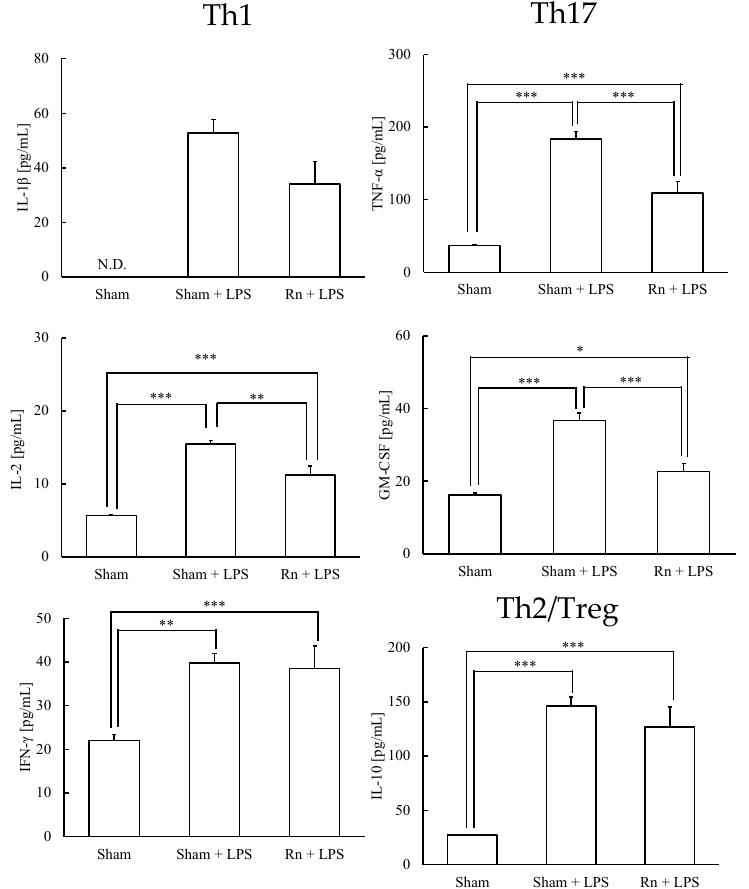
Figure 2. Effects of radon (Rn) inhalation on LPS-induced Th1-, Th17-, and Th2/Treg-prone cytokines in serum. The data show the mean ± SEM. N = 7; all experiments were conducted once. * p < 0.05, ** p < 0.01, *** p < 0.001; sham, mouse group without any treatment; sham + LPS, mouse group that inhaled sham followed by LPS (1 mg/kg body weight); Rn + LPS, mouse group that inhaled radon (2000 Bq/m 3 ) followed by LPS (1 mg/kg body weight); IL, interleukin; TNF, tumor necrosis factor; GM-CSF; granulocyte–macrophage colony-stimulating factor; IFN, interferon; N.D., not detected.